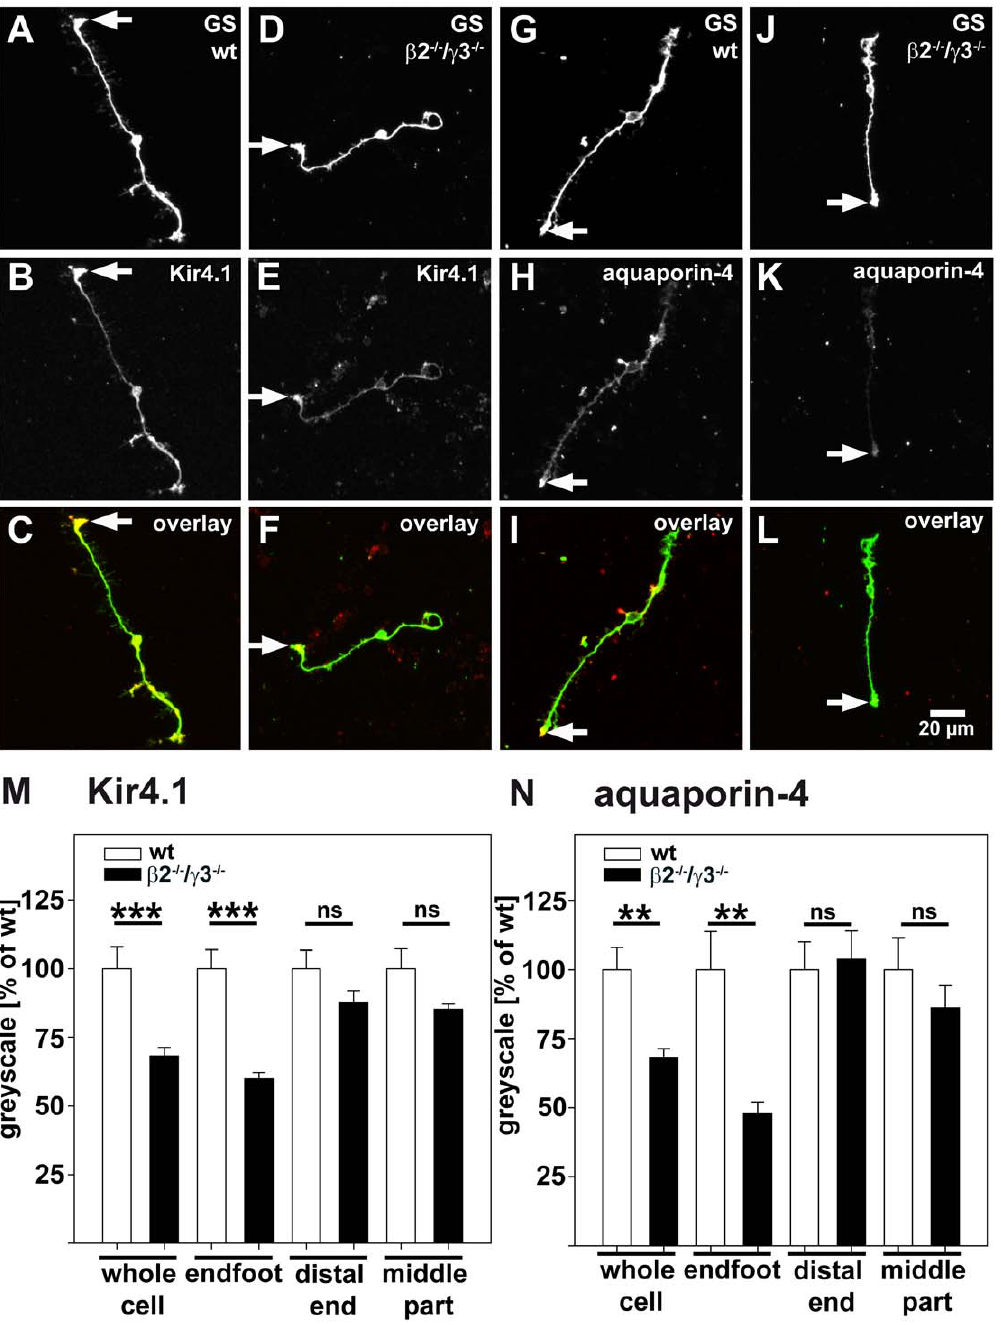
Figure 2. Immunocytochemical staining of acutely isolated Mu¨ller cells from b 2, c 3 laminin knockout mice. b 2, c 3 laminin knockout cells ( b 2 2 / 2 / c 3 2 / 2 ) are shown in panels D–F and J–L; wild-type controls in A–C and G–I. The expression of Kir4.1 (B, E) and aquaporin-4 (H, K) was analysed in glutamine synthetase (GS)-positive Mu¨ller cells (A, D, G, J). C, F, I, L show overlays of GS (green) and Kir4.1 (red, C, F) or aquaporin-4 (red, I, L) staining, respectively. Endfeet of the cells are marked by arrows. The staining was quantified as described in the methods. In Mu¨ller cells from b 2 2 / 2 / c 3 2 / 2 retinae the overall level of Kir4.1 staining (M) and of aquaporin-4 staining (N) quantified in whole cells was significantly lower as compared to wild-type Mu¨ller cells wild-types (wild-type: white bars; b 2 2 / 2 / c 3 2 / 2 : black bars). These differences are mainly due to highly significant changes in endfeet expression levels of both proteins (M, N). Numbers of cells analysed was between 22 and 28 for wild-types and between 30 and 66 for b 2 2 / 2 / c 3 2 / 2 mice; *** P # 0.001, ** P , 0.01.